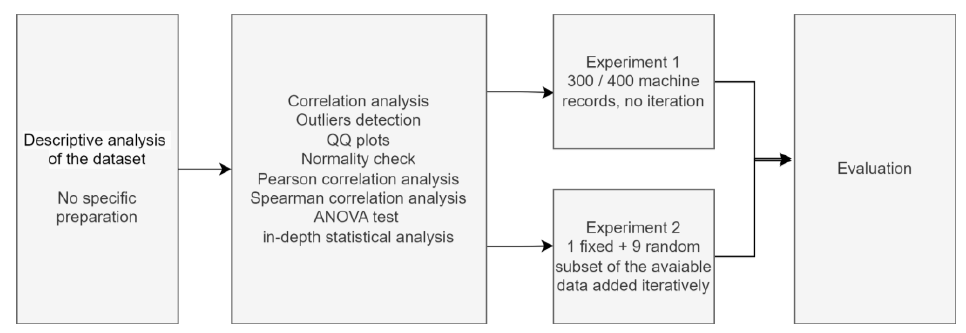
Figure 2. The workflow followed in the research.